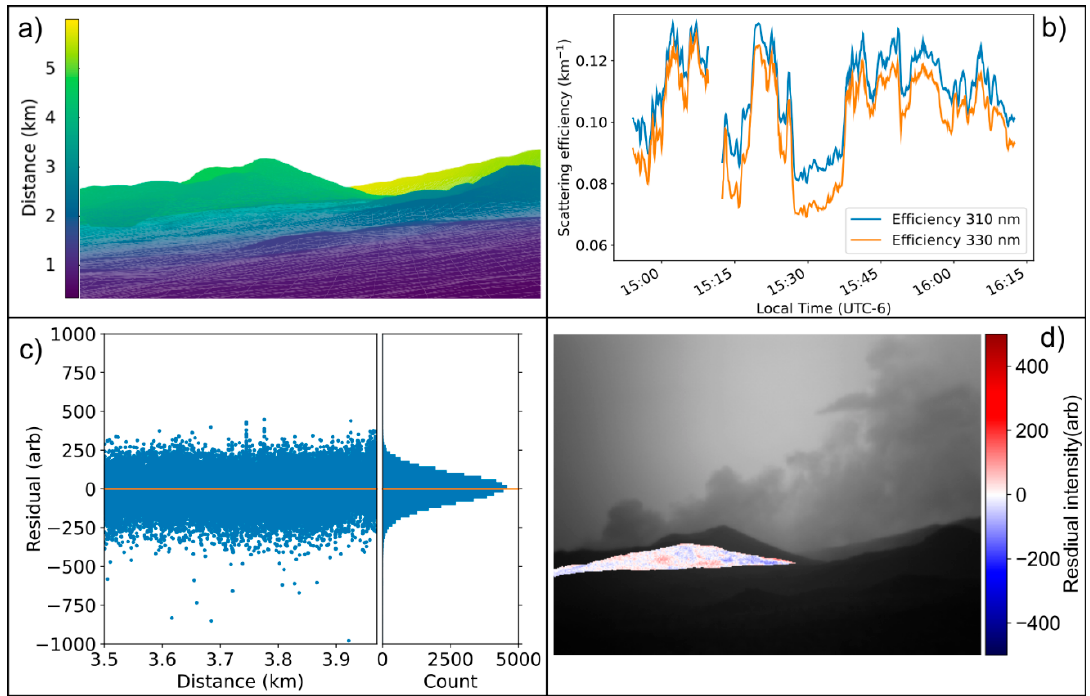
Figure 2. ( a ) Distances to the terrain from the camera calculated from NASA Shuttle Radar Topography Mission (SRTM) data. The distances to the triangulated mesh are rendered at their predicted position within the UV camera field of view. The setup shown is for the 13 January 2018; ( b ) the retrieved scattering efficiencies for the 310 and 330 nm camera for the whole of the 13th January; ( c ) the fitting residual of the 310 nm efficiency for the final camera frame, captured at 16:12 local time, as measured by the difference between the actual and predicted intensity of the edifice. A histogram shows the distribution of the residual; ( d ) the raw 310 nm image captured at 16:12 by the SO 2 camera, showing the plume emitted by Masaya (greyscale). In red and blue are the residuals shown in ( c ) as plotted on the edifice.